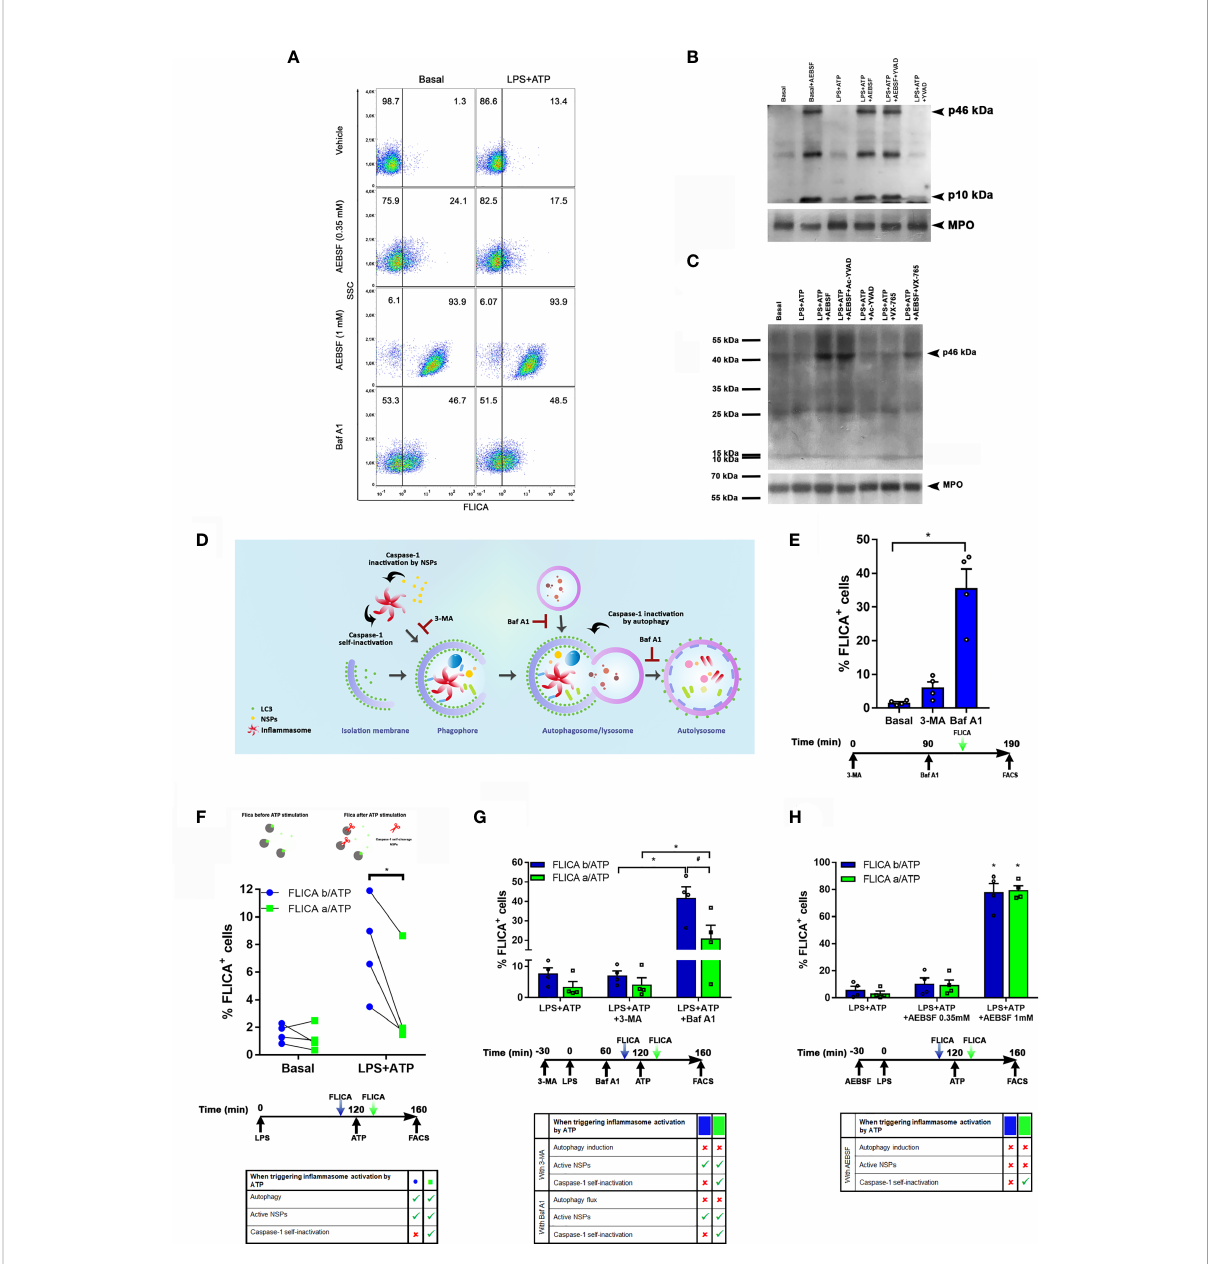
FIGURE 4 Caspase-1 activity is regulated by autophagy, self-inactivation and by NSPs. (A) Neutrophils were pre-treated or not with AEBSF (t= -30 min), then stimulated or not with LPS (t= 0); and treated or not with Baf A1 (t= 1 h). At 1 h 50 min the FLICA probe was added and in fl ammasome activation was stimulated by ATP at 2 h and cells were assessed at 2 h 40 min by fl ow cytometry. Dot plots are representative of experiments with 4 donors. (B and C) Immunoblot analysis of caspase-1 in lysates of human neutrophils pre-treated or not with AEBSF (0.35 mM), Ac-YVAD- CMK (50 m M), VX-765 (50 µM) or AEBSF and the corresponding caspase-1 inhibitor together, at t= -30 min, then stimulated or not with LPS (t=0) and ATP (t= 2 h) and assessed at 3 h 30 min post-LPS stimulation. MPO levels are shown as loading control. Immunoblots are representative of 3 (B) and 2 (C) independent experiments. (D) Rationale model to explain how the different inhibitors would impact on caspase- 1 activity and its detection. (E) Neutrophils were treated or not with 3-MA or Baf A1 as indicated in the schedule below the graph, stained with the FLICA probe and cell fl uorescence was determined by fl ow cytometry. (F – H) Neutrophils were treated as indicated in the schedule below each graph. Where indicated the FLICA probe was added 10 min before (b/ATP; blue symbols/bars) or 10 min after (a/ATP; green symbols/bars) in fl ammasome activation by ATP, and fl uorescence was determined by fl ow cytometry. (F; top part) depicts the rationale of the assay; grey: caspase-1, green: FLICA probe, red scissors: proteolytic cleavage. *p<0.05 (D) One way ANOVA followed by Sidak ’ s multiple comparisons test; (E) Paired t test; (F – G) Two-way ANOVA followed by Tukey ’ s multiple comparisons test. #p<0.05 (F) Two-way ANOVA followed by Sidak ’ s multiple comparisons